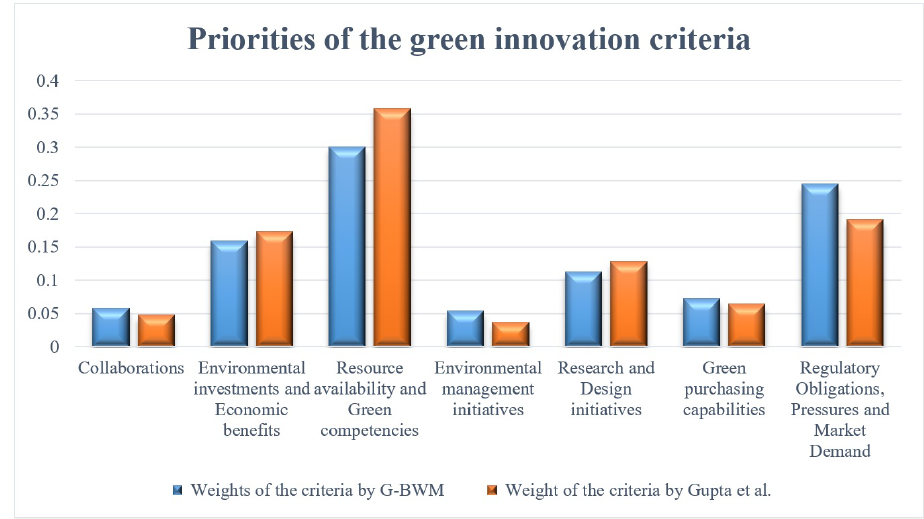
Figure 5. Priorities of the green innovation